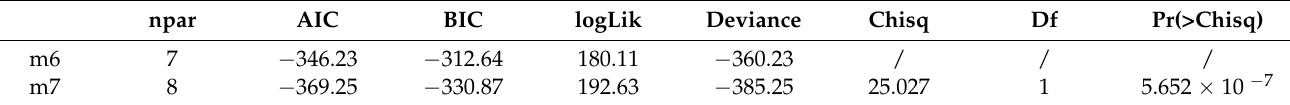
Table A5. Effect of light on the growth rate in plant diameter.